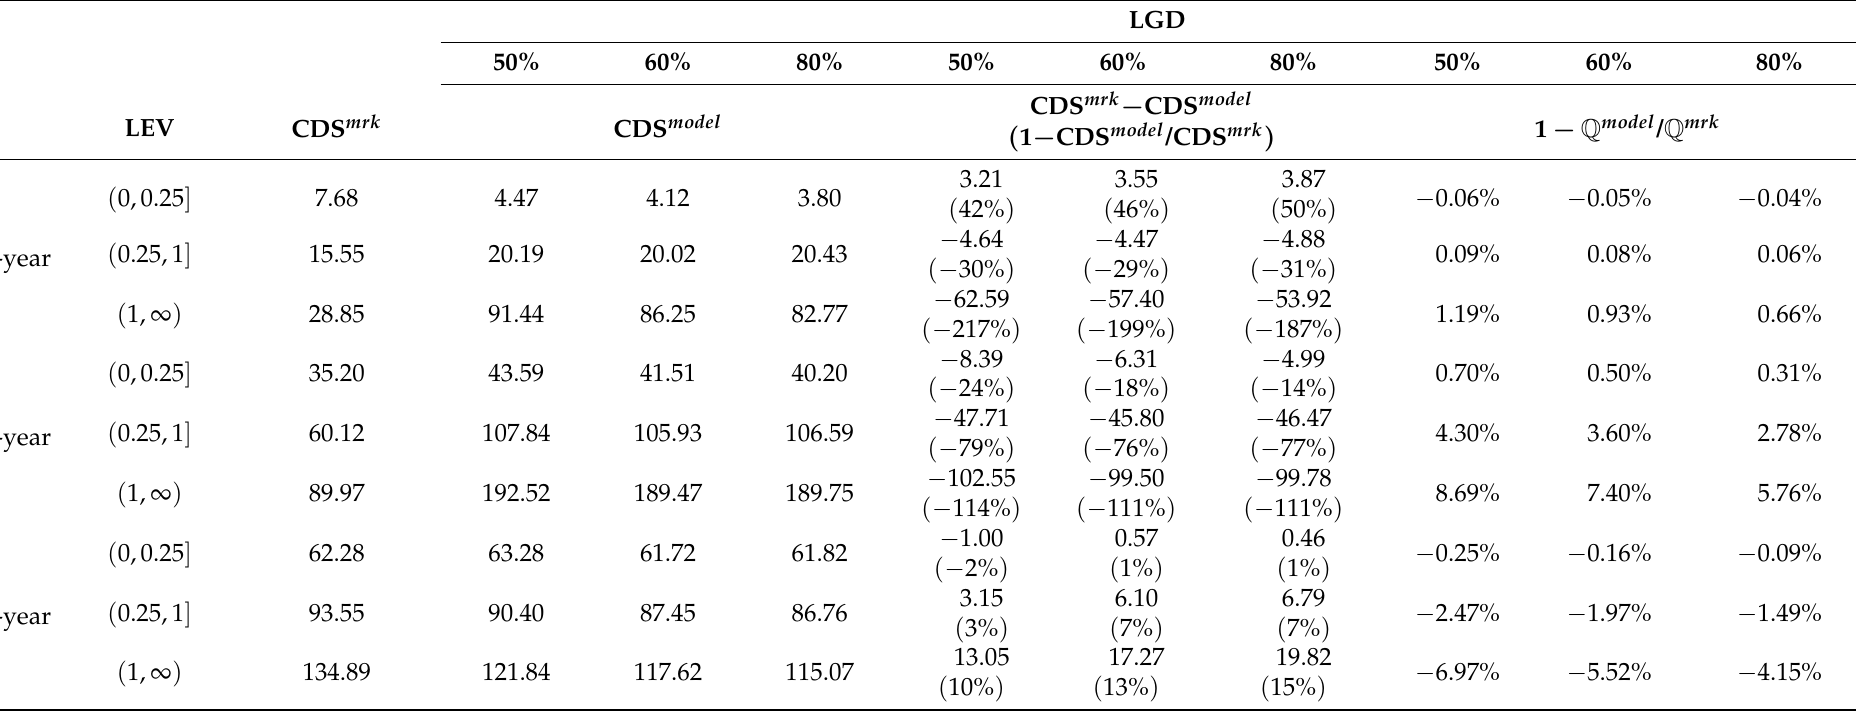
Table 2. Pricing error of the CDS spread and risk-neutral probabilities of default for w = 1/2. All the model-implied spreads are calculated setting the loss given default equal to 50%, 60% or 80%. This allows to jointly test for the effect of the aggregation scheme in the firm’s capital structure and on the selected value of LGD. The table reports the market CDS spread alongside those produced by the model (expressed in basis points) based on the estimates of the firm’s asset and volatility on the previous week. The results are clustered based on the maturity of the CDS contract (1, 5, and 10 years) and on the firm’s average leverage. A positive/negative pricing error CDS mrk − CDS model indicates that the model under/overpredicts the level of the spread. This is reflected into the over/underprediction of the survival probabilities. Errors are also reported as percentages in brackets. For the probabilities of survival, only percentage errors are reported. Based on leverage, the number of companies in each bucket are N low = 44, N med = 15, N high =